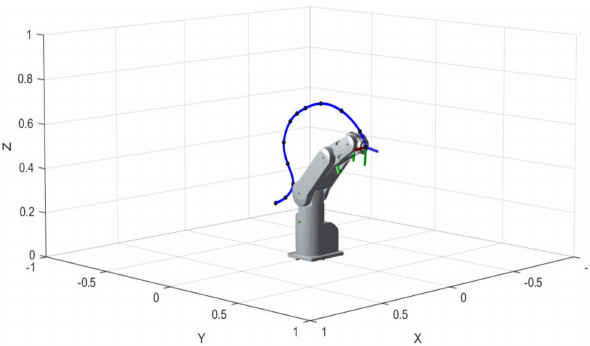
Figure 12. Visualization of the execution of the improved trajectory by RV-2AJ arm.